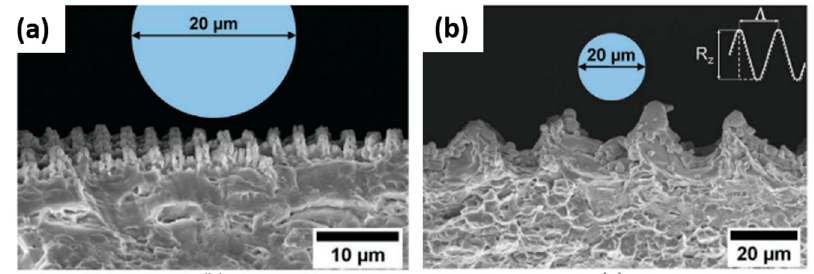
Figure 13. Side view SEM image of two laser textured surfaces with a spatial period ( a ) bigger than and ( b ) comparable to a water droplet of 20 µ m. (Reproduced from [124] under http: // creativecommons. org / licenses / by / 4.0 /